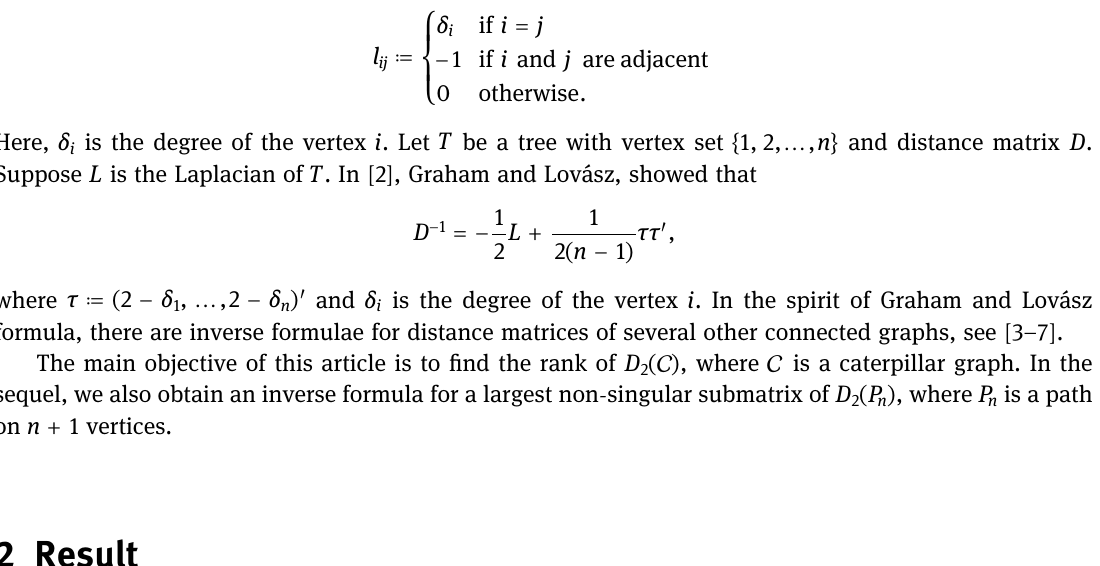
Figure 2: A caterpillar graph.